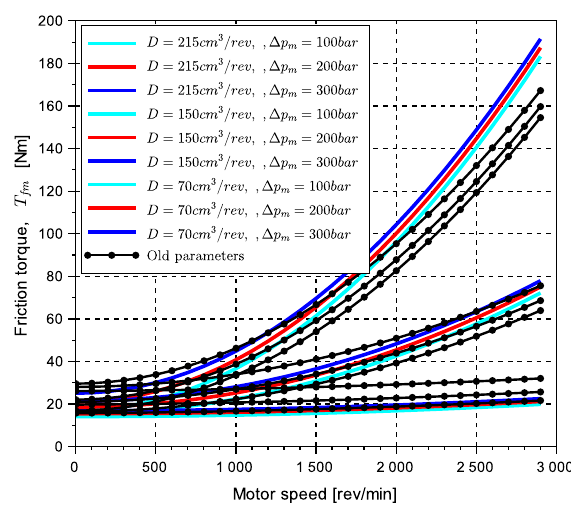
Figure 10: New motor parameters compared to old.